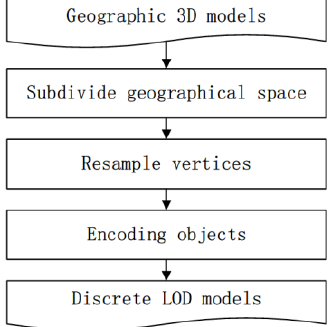
Figure 1. A framework of the encoding method